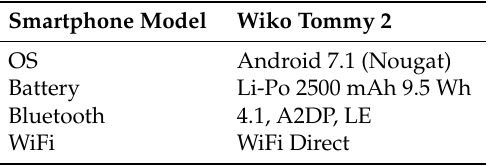
Table 1. Smartphones main